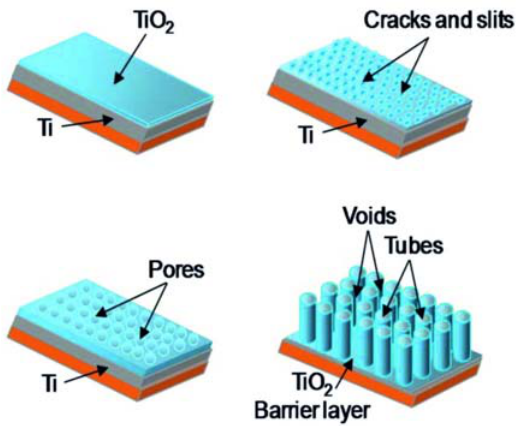
Figure 3. Schematic diagram of the evolution of TiO potentiostatic mode anodization. Reproduced from [39] by permission of The Royal Society of